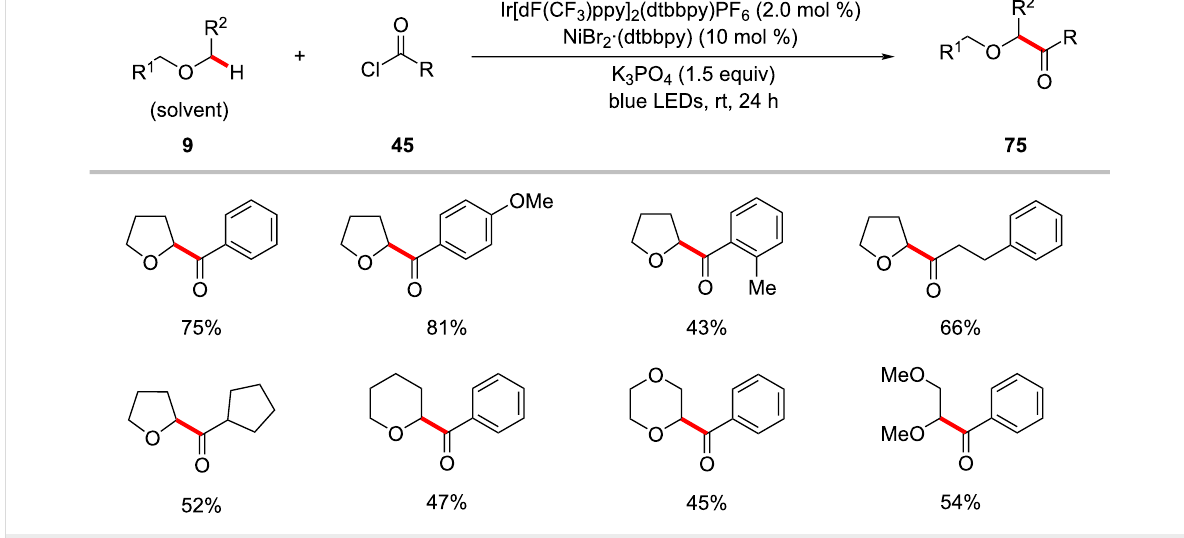
activator to convert the carboxylic acid to a mixed anhydride in situ. In this protocol, the bisoxazoline-based chiral ligand 83 enabled the synthesis of α -amino ketones in high enantioselec- tivities under mild reaction conditions. Good yields were